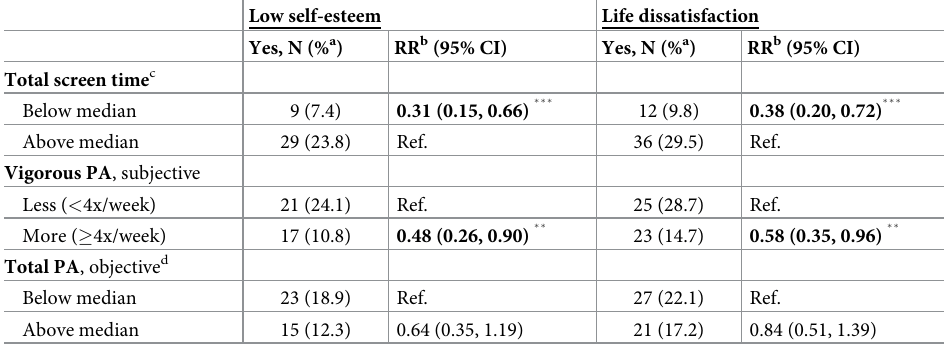
Table 3. Associations of screen time and physical activity with low self-esteem and life dissatisfaction.